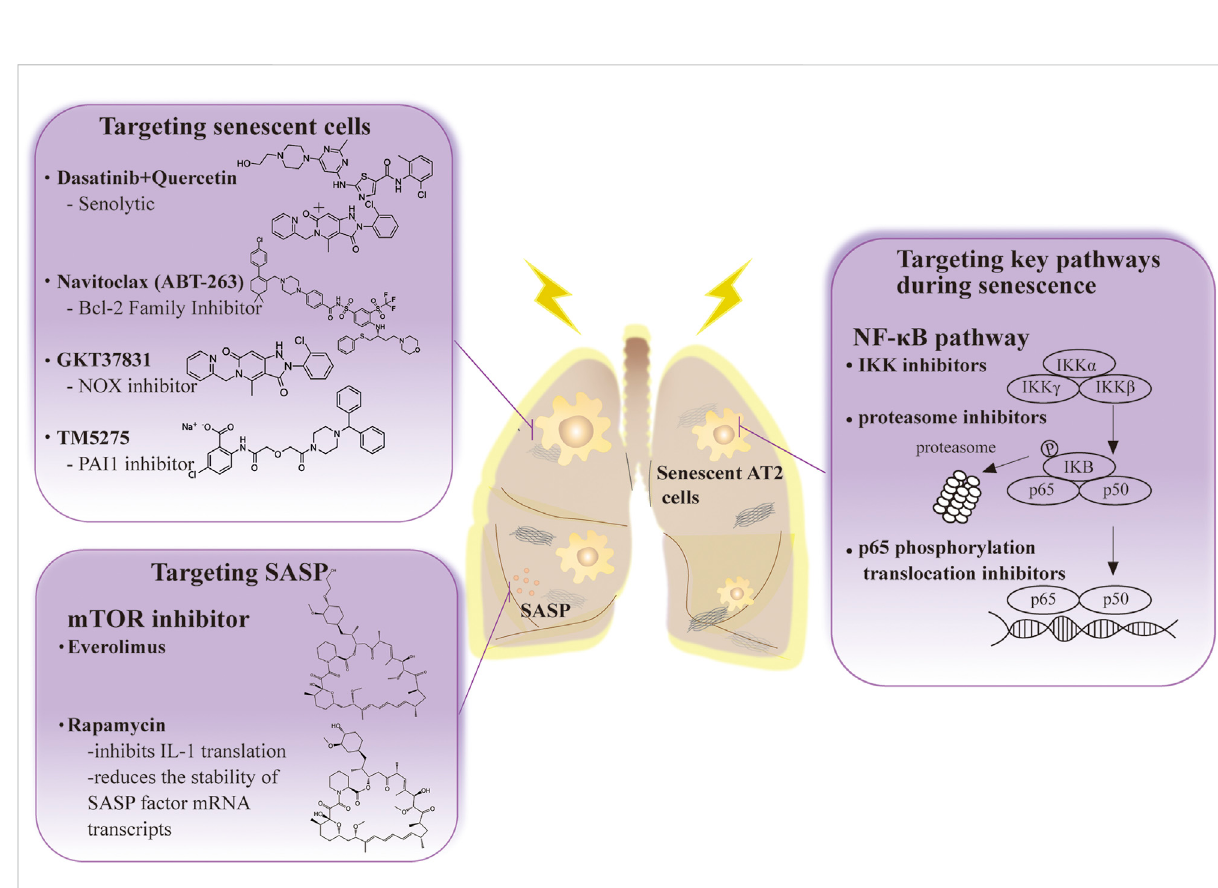
FIGURE 2 The anti-senescence therapy to prevent disease and extend healthy life span in RIPF.